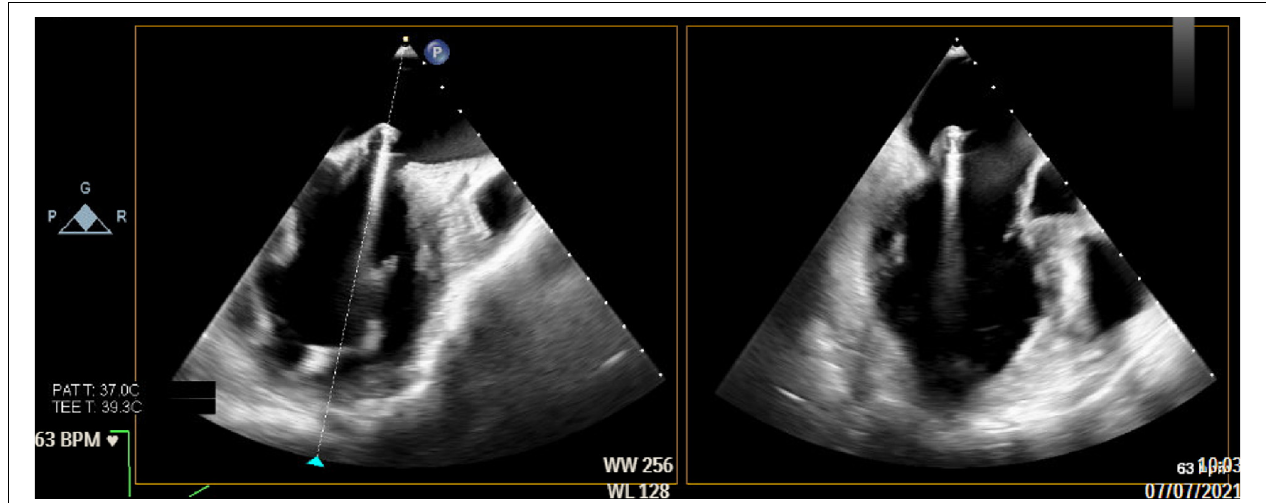
FIGURE 5 | The end effector is used to stabilize the HARPOON device on the underside of the pMVL at the targeted implantation site. pMVL, posterior mitral valve leaflet.